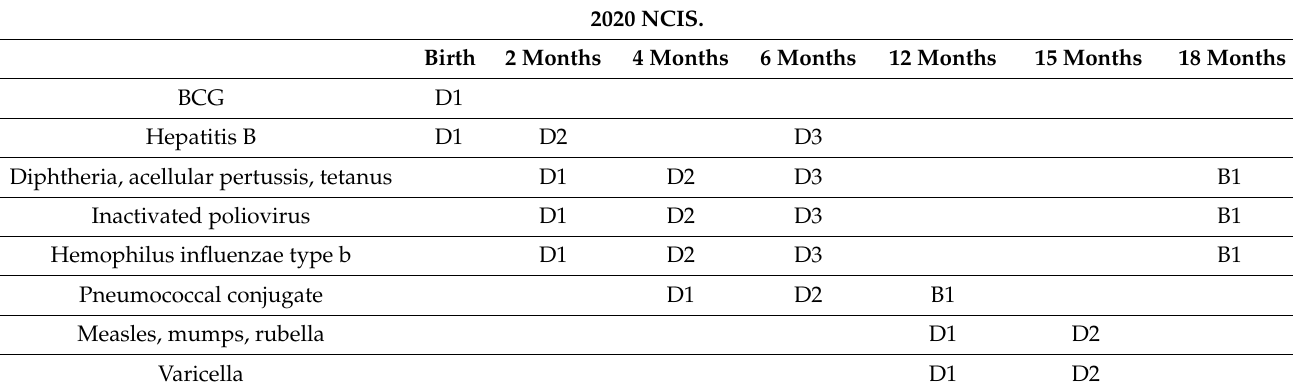
Table 2. New 2020 National Childhood Immunization Schedule (NCIS)